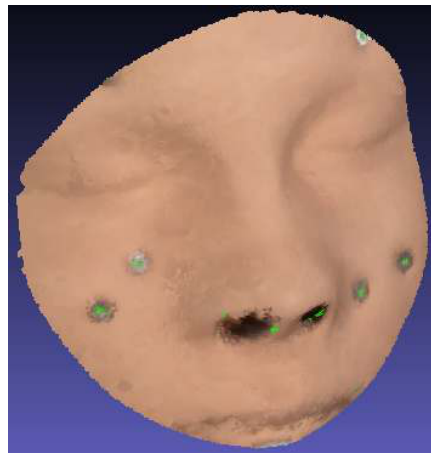
Figure 5: Phantom with screw heads defining reference locations. Green blob indicates automatic detection of the screw head. +0.9 mm and are comparable for x, y and z.